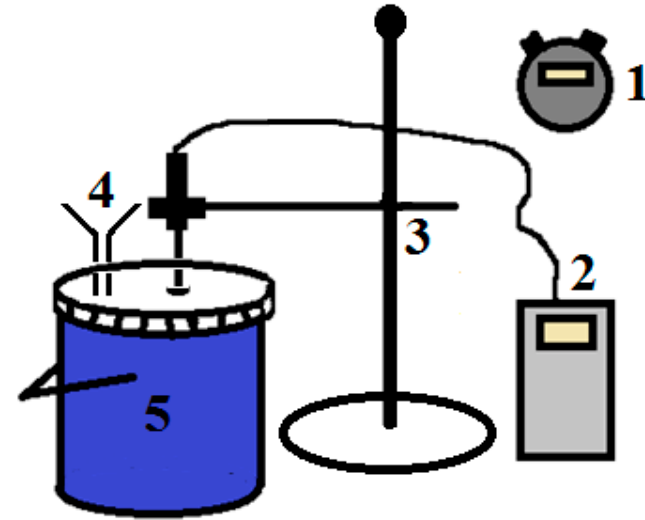
Figure 4. Diagram of stand used to test thermal effects of the neutralization process ( 1 ) Stopper, ( 2 ) electronic thermometer, ( 3 ) stand, ( 4 ) inlet, ( 5 ) Deware dish.